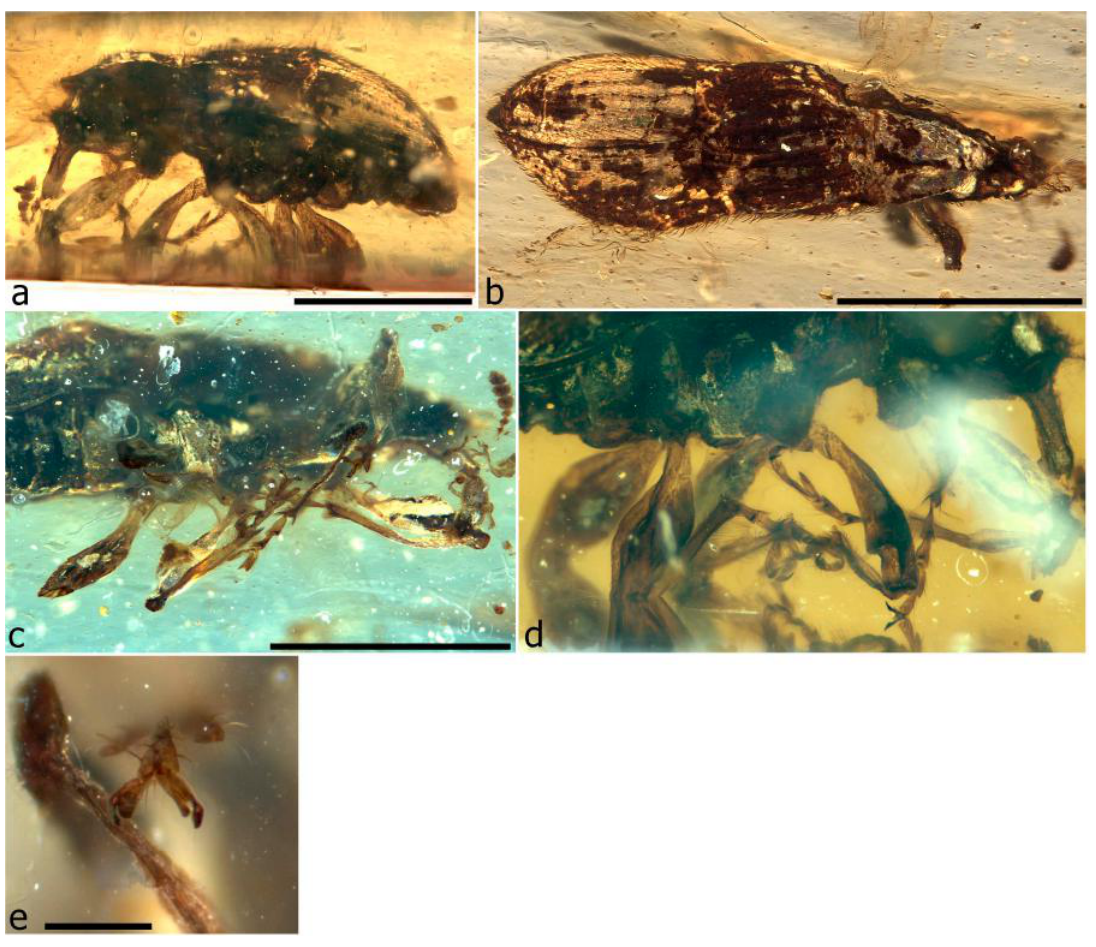
Figure 67. Compsopsarus sp. Habitus, left lateral ( a ); habitus, dorsal ( b ); legs and ventrites, ventral ( c ); same, right lateral ( d ); claw, apical ( e ). Scale bars: 1.0 mm (a–c); 0.1 mm (e). Genus Myanmarus Clarke & Oberprieler, gen. n.